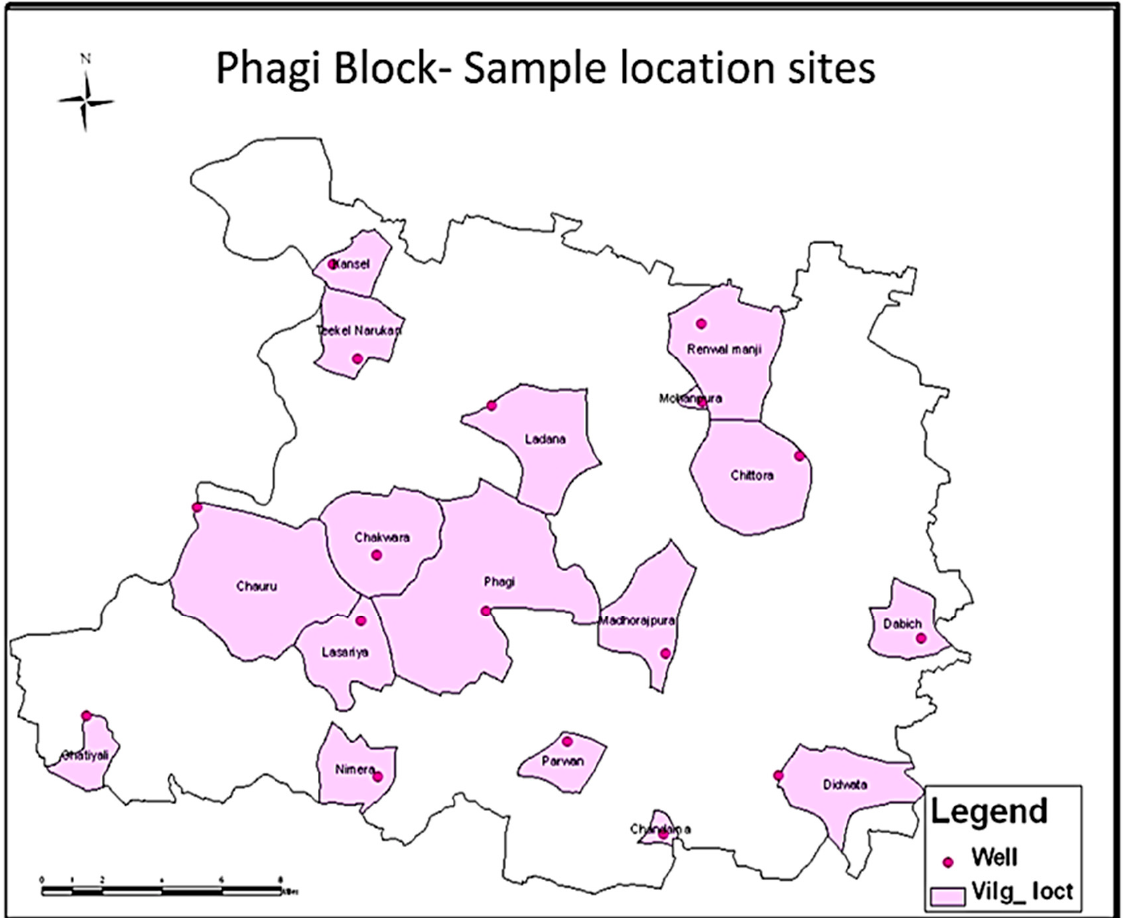
Figure 2. Water sample location sites (16 well locations, Phagi Block, Rajasthan, India (Source—Primary Data).